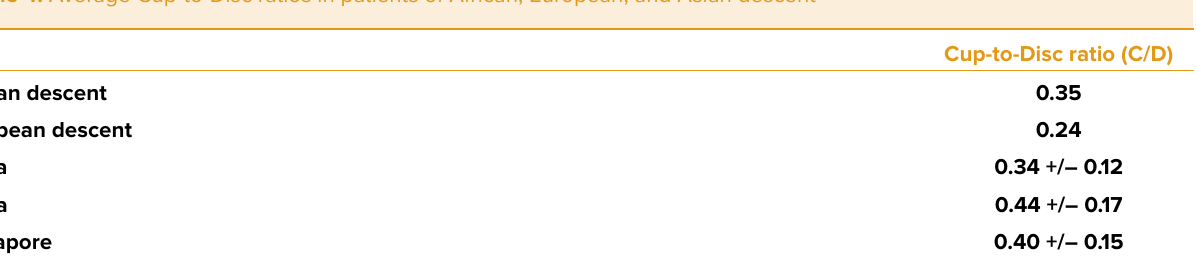
Table 4. Average Cup-to-Disc ratios in patients of African, European, and Asian descent [46–48]